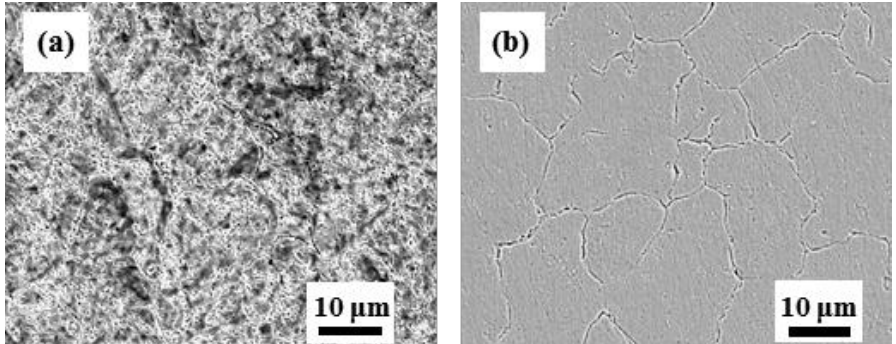
Figure 2. Microstructures of chemically etched specimens (Viella’s reagent for 5 s): ( a ) specimen A; ( b ) specimen B.